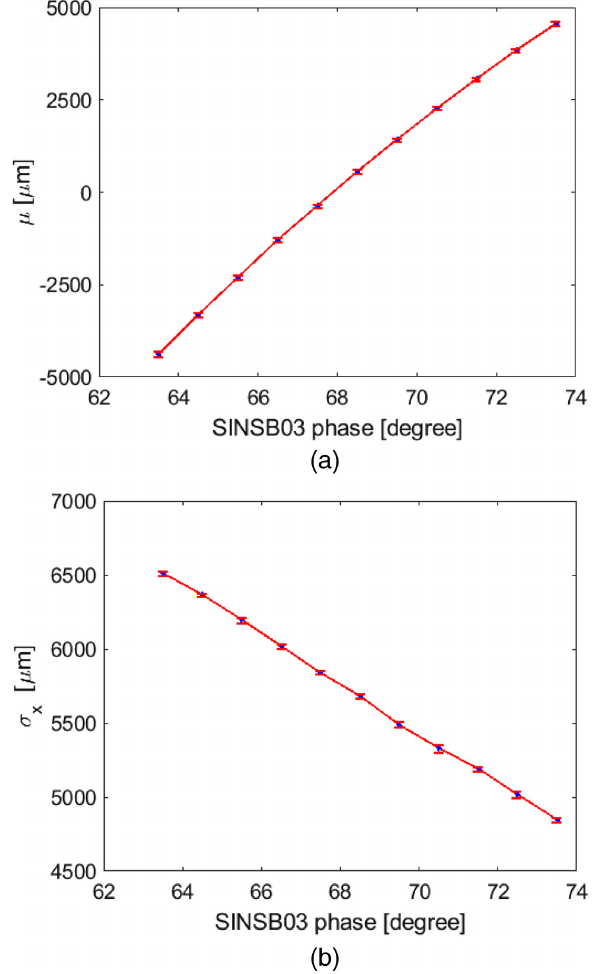
FIG. 4. SRM measurements of (a) the centroid and (b) the rms size of the horizontal beam distribution as a function of off-crest phase of the S-band. A measurement of the relative variation of the beam mean energy and the relative energy spread Δ E the electron beam can be obtained by normalizing the plotted data by the nominal dispersion of the first magnetic chicane [ η ¼ 447 . 53 mm at a bending angle of 4.09°, see also Eq. (5)].